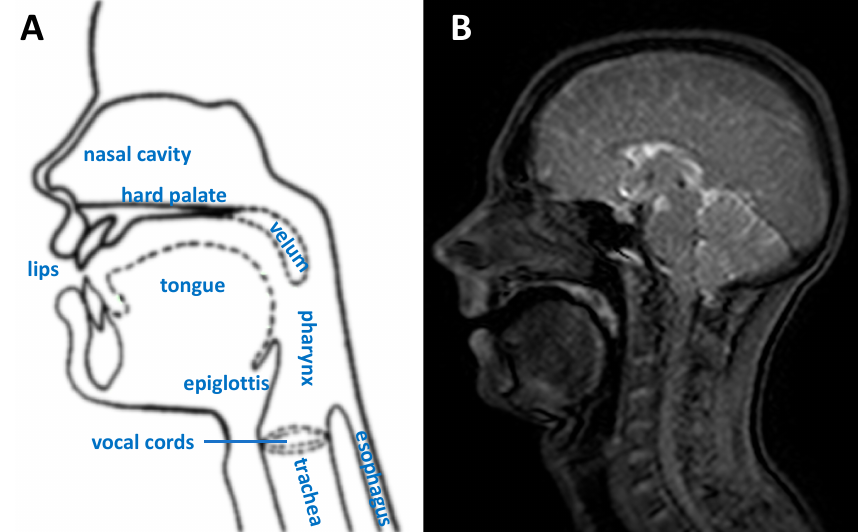
Figure 1. ( A ) A mid-sagittal diagram of the upper vocal tract highlighting the main speech organs or articulators. ( B ) A corresponding typical frame from a dynamic MRI scan during speech.